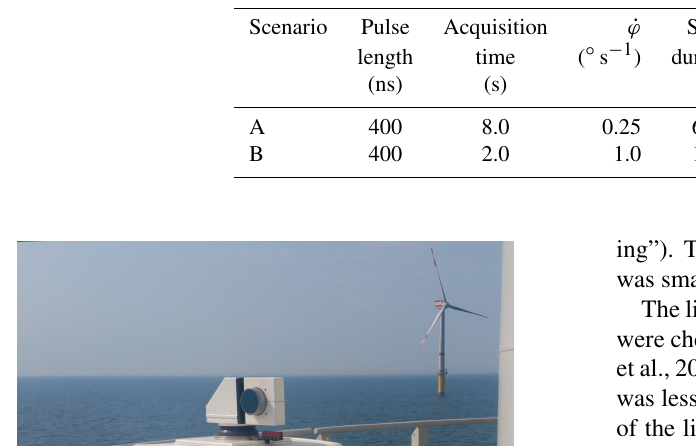
Table 2. Overview of the different settings for the lidar plan position indicator (PPI) scans. Both scenarios covered different sectors of 150 ◦ width. Range gates are listed as minimal range : spacing : maximal range. Range gates are also referred to as “measurement points” in the following.